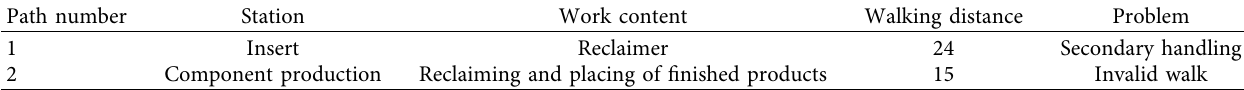
Table 1: Analysis of walking distance in the workplace.